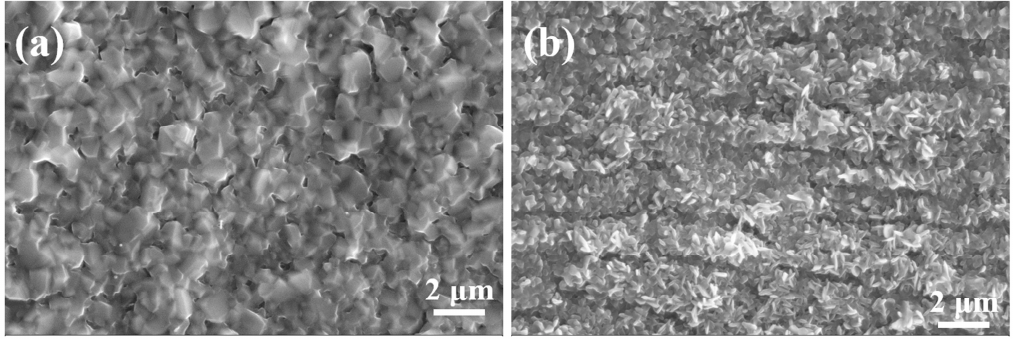
Figure 12. The micrographs of the surface morphology of the investigated alloys after isothermal oxidation at 900 °C for 100 h, ( a ) as-cast alloy, ( b ) as-sintered alloy.